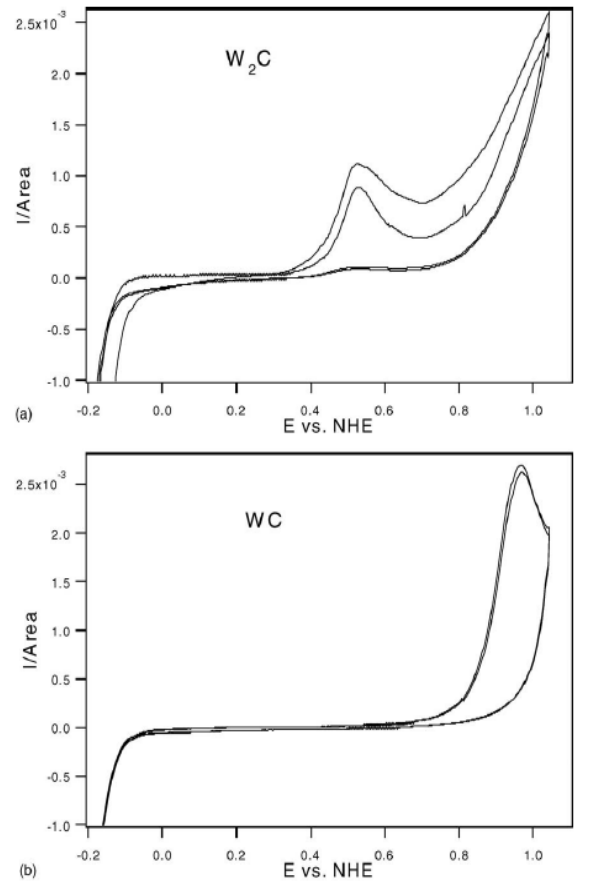
Figure 2. Electrochemical CV measurements performed in 0.5 M H of W C and WC films on carbon paper (Reprinted from Reference 66 with 2